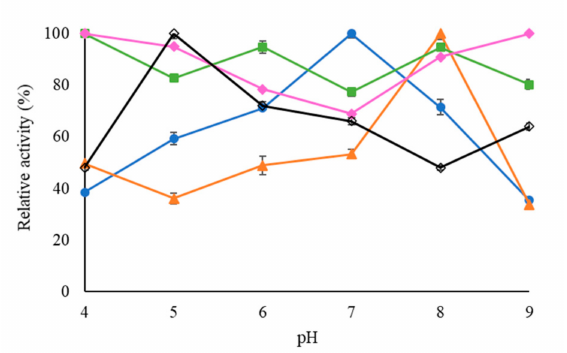
Figure 4. Effect of pH on the activity of different preparations of USBA-GBX-513 lipase on: Empty rhombi: free USBA-GBX-513; blue circles: OC-USBA-GBX-513; orange triangles: OC-GLX-USBA- GBX-513; green squares: Q-Sepharose-USBA-GBX-513; pink rhombi: CNBr- USBA-GBX-513 versus p -NPB. Experiments were performed as described in the